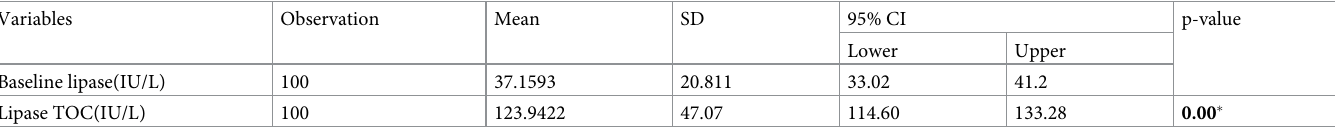
All independent variables were checked by bivariate regression (p < 0.25) to perform multivari- ate analysis. During multivariate analysis, age (r = 2.11, p = 0.05) and lipase line (r = 0.5, p = 0.025) were found significantly associated with serum lipase after treatment. It indicates the presence of a one year increase in age increases serum lipase at TOC by 2.11 and a one unit increase in base line serum lipase increase serum lipase at TOC by 0.5. Multiple linear regres- sion of Serum lipase after treatment with different variables in a patient taking sodium stibo- gluconate/paromomycin drugs (as shown in Table 7). Table 4. Paired t-test comparing serum pancreatic lipase before and after treatment.